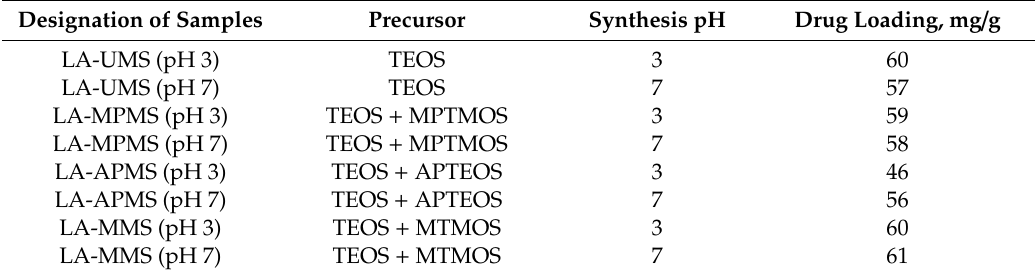
Table 1. Designation of synthesized composites, their synthesis conditions and amount of loaded drug. Designation of